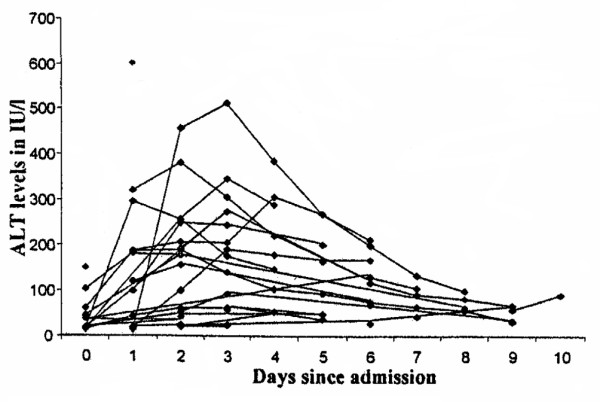
Alanine aminotransferase (ALT) levels in infants with respiratory syncytial virus infection ventilated on a paediatric intensive care unit.